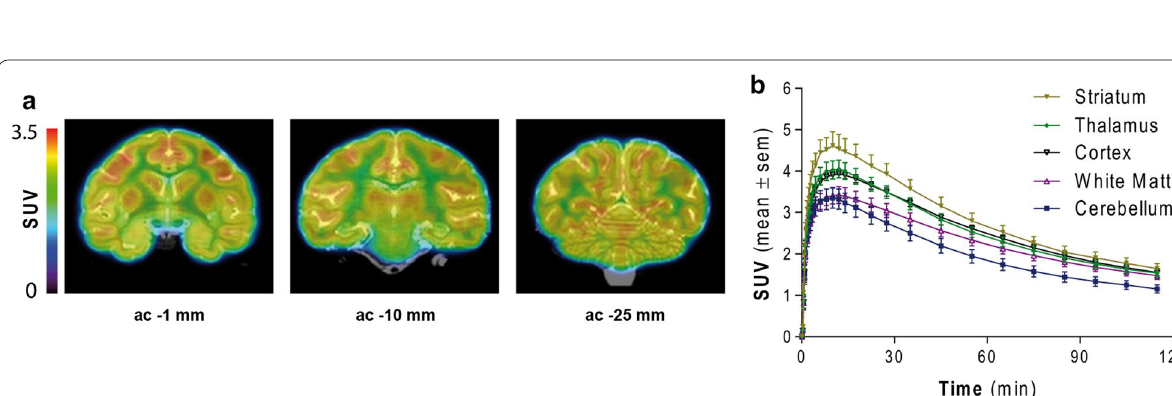
SEM) metabolite-corrected plasma ±